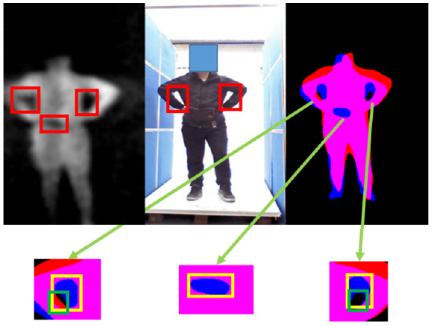
Figure 6. Illustration of our false alarm elimination strategy. The false alarms caused by the arm in the PMMWI have similar textural features to the threats, and it is difficult to be excluded only by the information from PMMWI. Using the registered VI to check the IOU of the corresponding area will help eliminate such type of false alarms. The yellow box in the second row is the suspicious area in PMMWI, and the green box represents the area extracted from the VI.